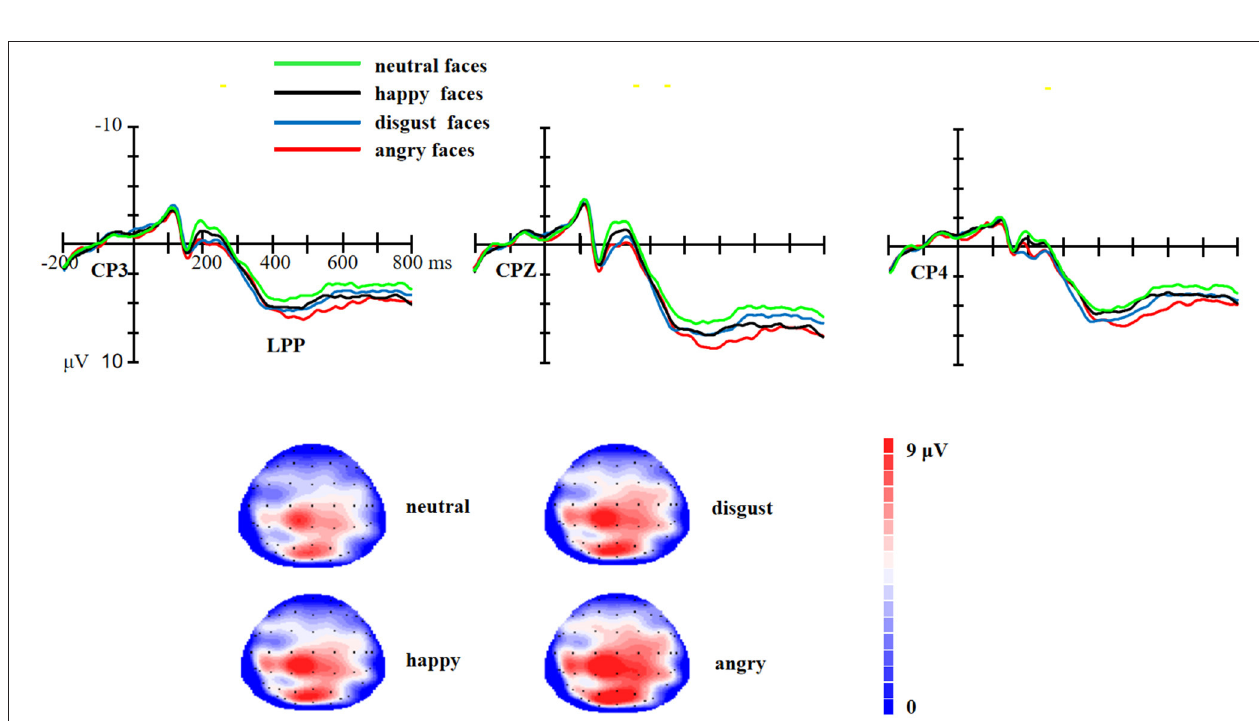
FIGURE 4 | Upper: The ERP waveforms for angry, disgust, happy, and neutral facial expressions at CP3, CPZ, and CP4 electrode sites. Bottom: The scalp distribution of the LPP (350–600ms) for angry, disgust, happy, and neutral facial expressions.